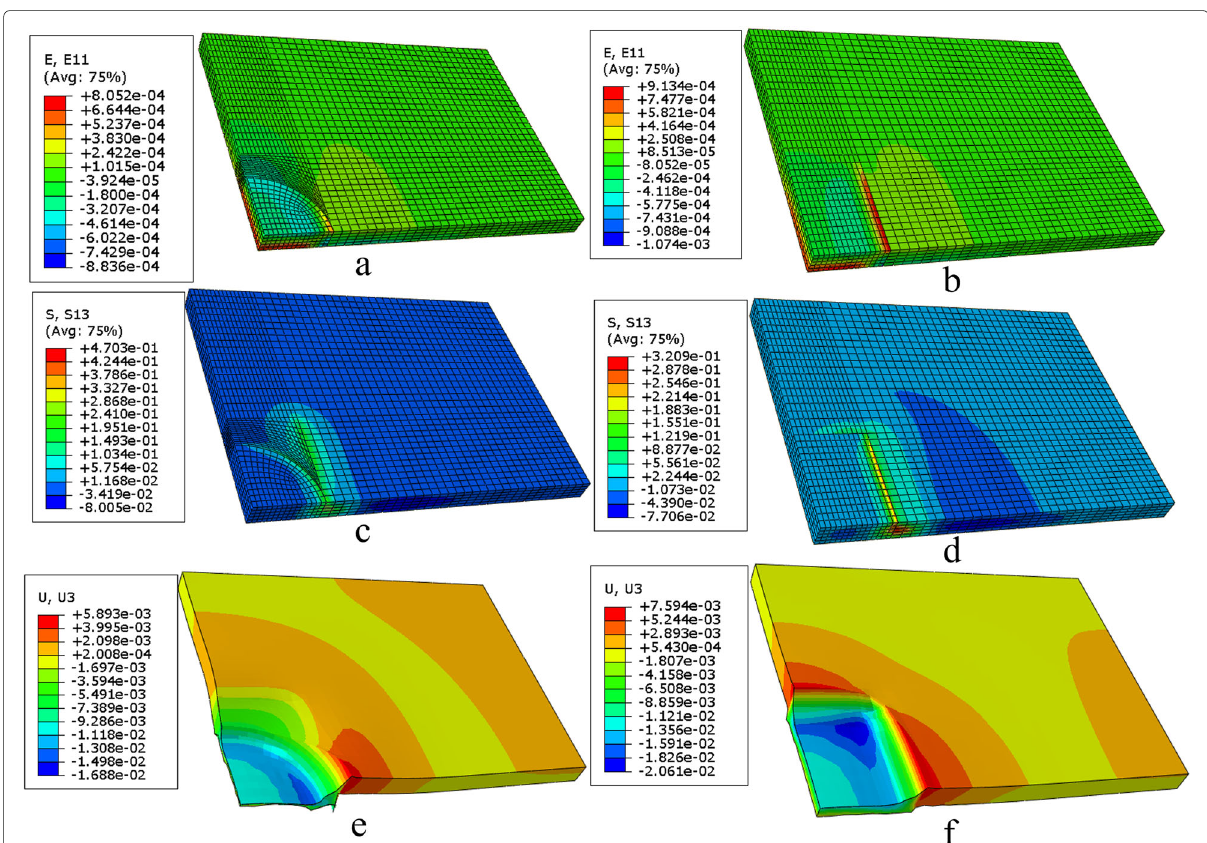
Fig. 9 Comparisons of circular and rectangular shape for medium repairs, a and b are horizontal strain (E11) at 0.17s, c and d are shear stress (S13) at 0.17s, e and f are vertical deformation (U3) at 59.03s